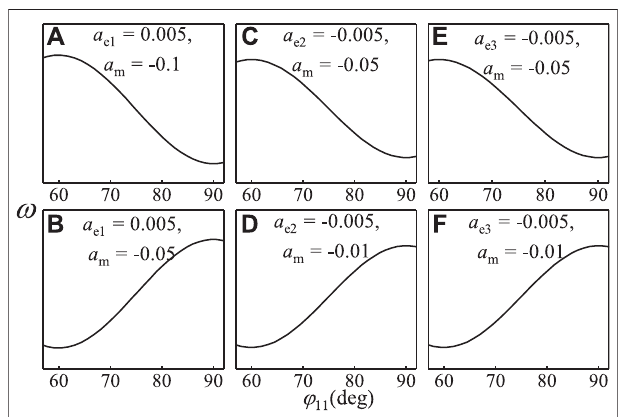
FIGURE 4 | Combined effects of the exchange and fourth order magnetocrystalline anisotropies on SkX. The absolute value of exchange anisotropy coef fi cient is fi xed to be 0.005, the value of magnetocrystalline anisotropy coef fi cient is fi xed to be − 0.1 or − 0.05 or − 0.01. The results are calculated at ψ (cid:2) 90 + , b (cid:2) 0 . 2 and t (cid:2) 0 . 5.